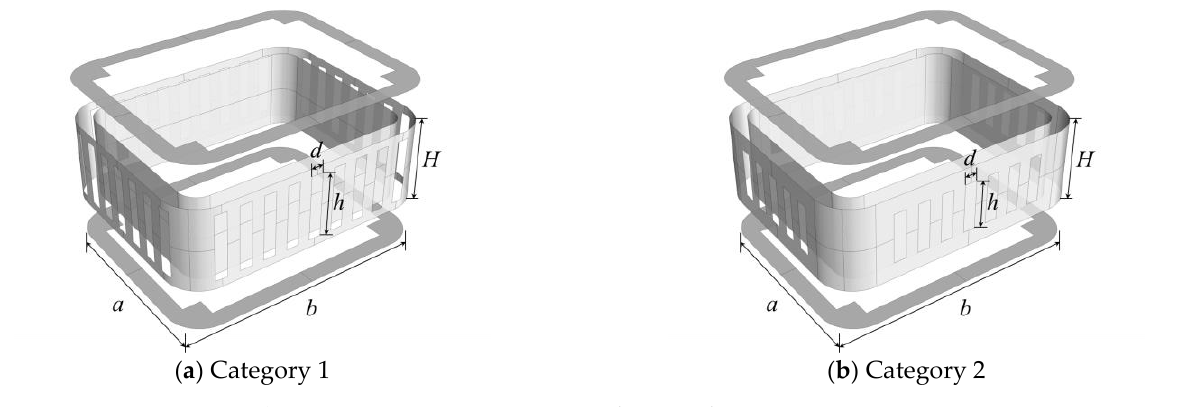
Figure 2. Passive jet ring structure schematic diagram.